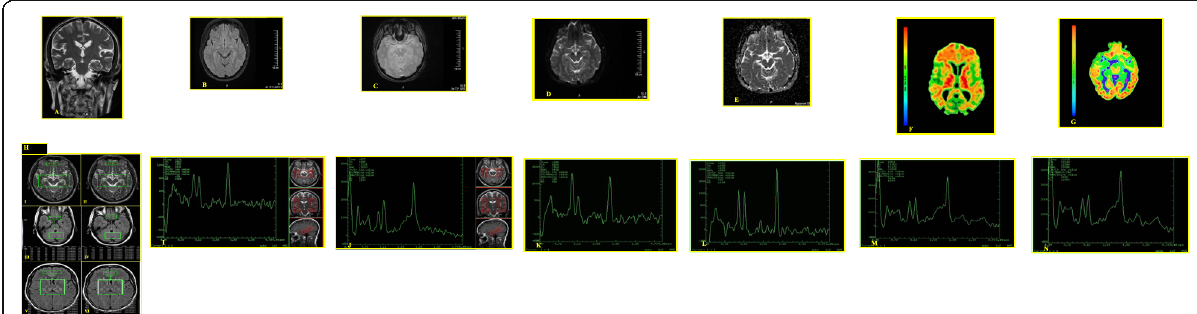
Fig. 1 a – n A 42-year-old male with right temporal lobe FIAE. The structural MR images, including coronal T2WI ( a ), axial FLAIR image ( b ) and axial T2*-GRE image ( c ), as well as axial DWI and ADC at b value 0 s/mm 2 ( d and e , respectively), all are unremarkable and negative. The visual-based analysis of the axial cerebral PASL-MRI colour-coded cerebral perfusion maps ( f and g ) reveals no abnormal perfusion pattern. The MV 1H-MRS picture maps are demonstrated in ( h ) (I – VI). The MRS spectra of the right ( i ) and left ( j ) temporal lobes reflect the increase in MI/NAA, Glx/NAA and Glx/Cr, as well as the decrease in NAA/ (Cho + Cr) ratios in the zone of epileptogenic activity in the right temporal lobe ( i ) in comparison to the contra-lateral non-epileptic left temporal lobe ( j ), where these ratios for right and left temporal lobes, respectively, are [NAA/(Cho + Cr) = 0.44 and 0.81 with %AF = 29.6%, MI/NAA = 0.50 and 0.38 with %AF = 27.27%, Glx/NAA = 1.61 and 1.35 with %AF = 16.95%, as well as Glx/Cr = 1.59 and 1.33 with %AF = 17.81%], while the MRS spectra of the right ( k ) and left ( l ) thalami demonstrate a decrease in MI/NAA and NAA/(Cho + Cr), as well as increase in Glx/NAA and Glx/Cr peak concentration ratios in the ipsilateral right thalamus ( k ) compared to the contra-lateral left thalamus ( l ) with these ratios for right and left thalami, respectively, were [NAA/(Cho + Cr) = 0.45 and 0.56 with %AF = 21.78%, MI/NAA = 0.20 and 0.25 with %AF = 20%, Glx/NAA = 1.35 and 1.27 with %AF = 6.11% and Glx/Cr = 1.30 and 1.25, with %AF = 3.92%]. On the other hand, the MRS spectra of the right ( m ) and left ( n ) cerebellum, reveal trivial %AF in all concentration ratios [NAA/(Cho + Cr) = 0.76 and 0.74 with %AF = 2.66%, MI/NAA = 0.47 and 0.45 with %AF = 1.36%, Glx/NAA = 1.29 and 1.28 with %AF = 0.77% and Glx/Cr = 1.25 and 1.24 with %AF = 0.80%]. The clinical examinations and EEG studies confirmed our